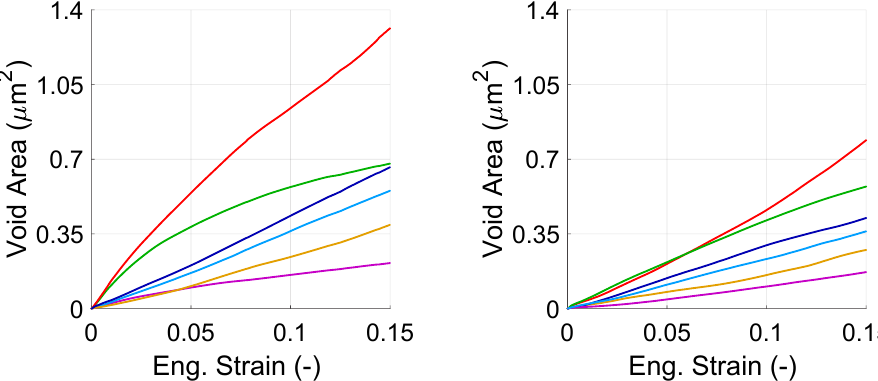
Figure 15. Evolution of the area of individual voids formed by martensite cracking in banded ( left ) and random ( right ) morphology with total strain. Each color represents one